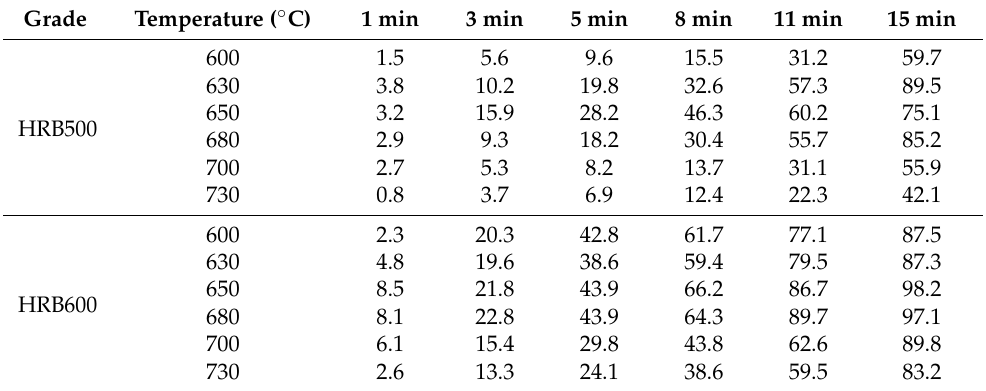
Table 4. Volume percentage of ferrite in the samples held at different temperatures for different durations.